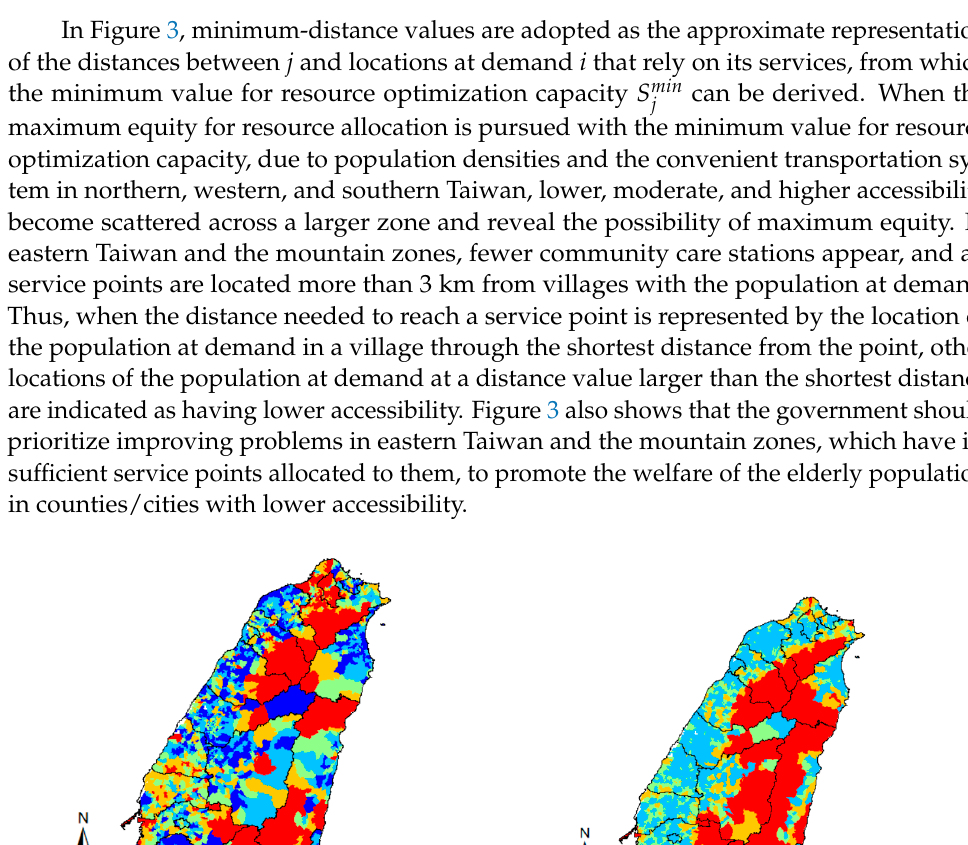
Figure 2. Accessibility score of community care stations in Taiwan using methods M0 and M2.